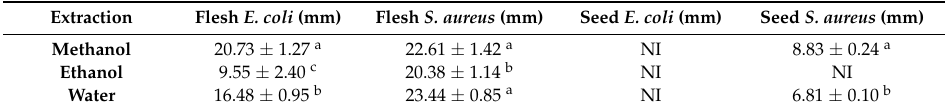
Table 2. Antimicrobial activity by disc diffusion assay of the green plum flesh and seed, results as diameter of inhibition zone in mm using a 6 mm disc.